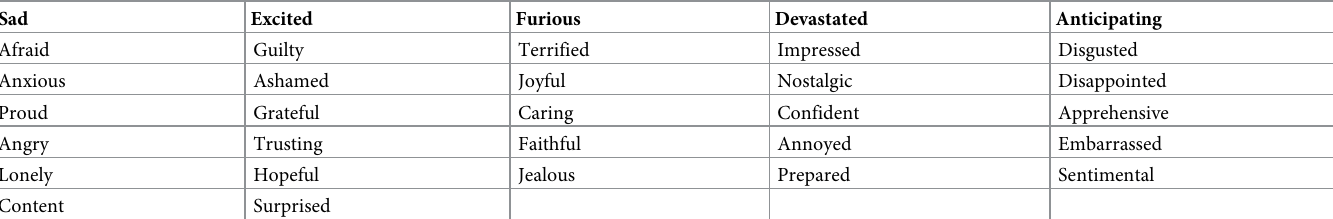
Table 1. Emotional category of Empathetic Dialogue